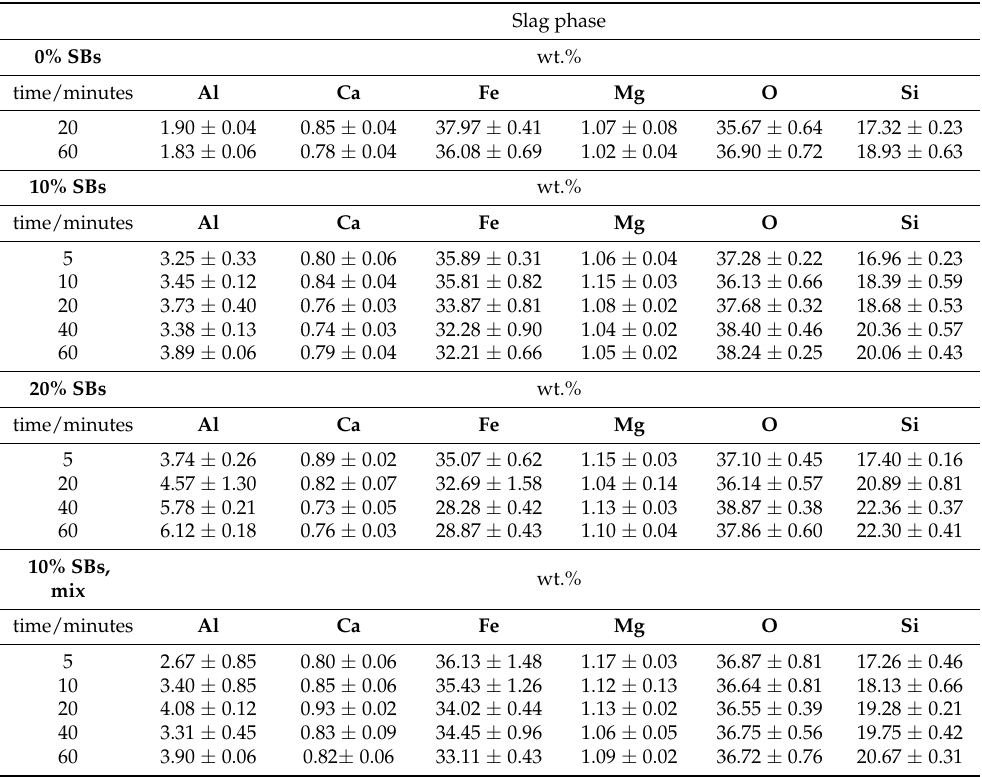
Table A2. Chemical concentration of major elements in the slag phase analyzed with SEM-EDS.